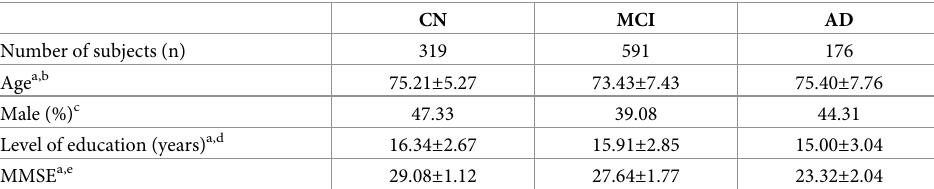
Table 1. Demographic characteristics of the study